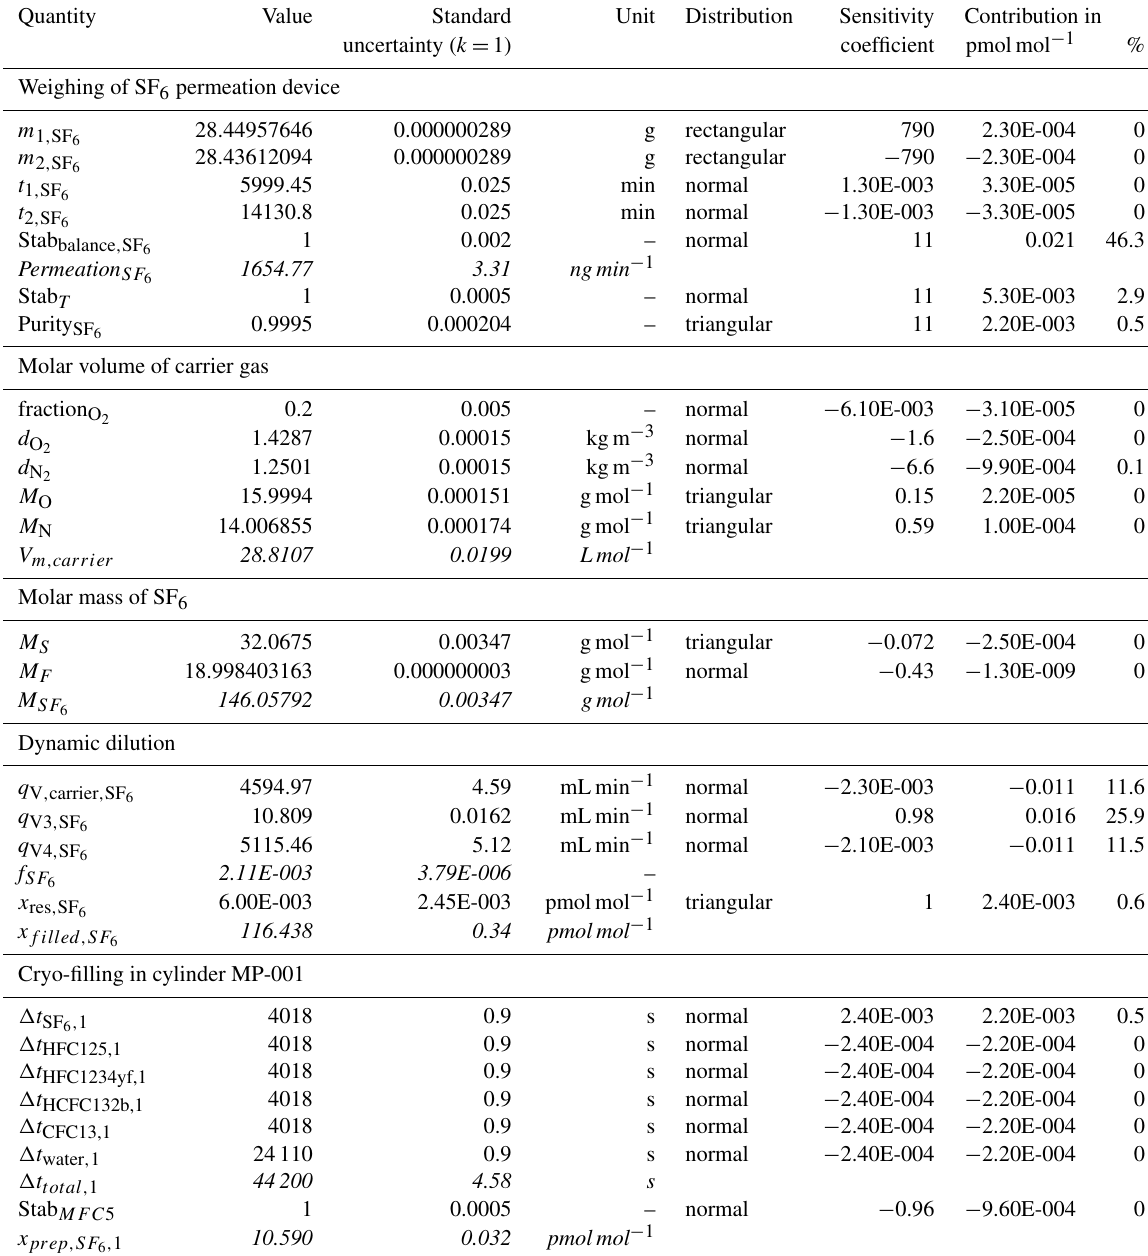
Table 2. Primary reference gas mixtures for SF 6 filled in cylinder MP-001: list of variables taken into account in the uncertainty budget. Variables and corresponding numbers in italic are intermediate results. To fill SF 6 in the other cylinders, only the filling durations were modified (i.e. last section in this Table); all other input values remained unchanged. Input values used to calculate molar fractions and expanded uncertainties for the other substances can be found in the Supplement Tables S1, S2 and